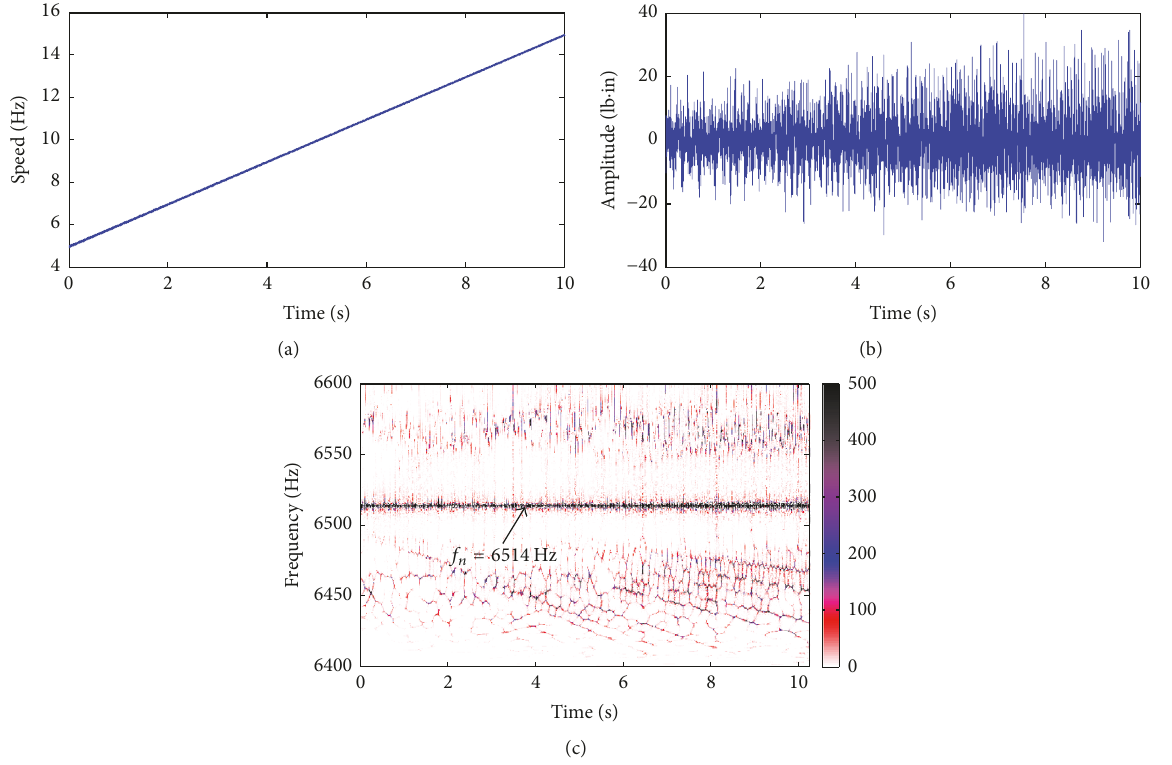
Figure 10: Resonance frequency identification: (a) drive motor speed, (b) detrended torsional vibration signal, and (c) reassigned Morlet